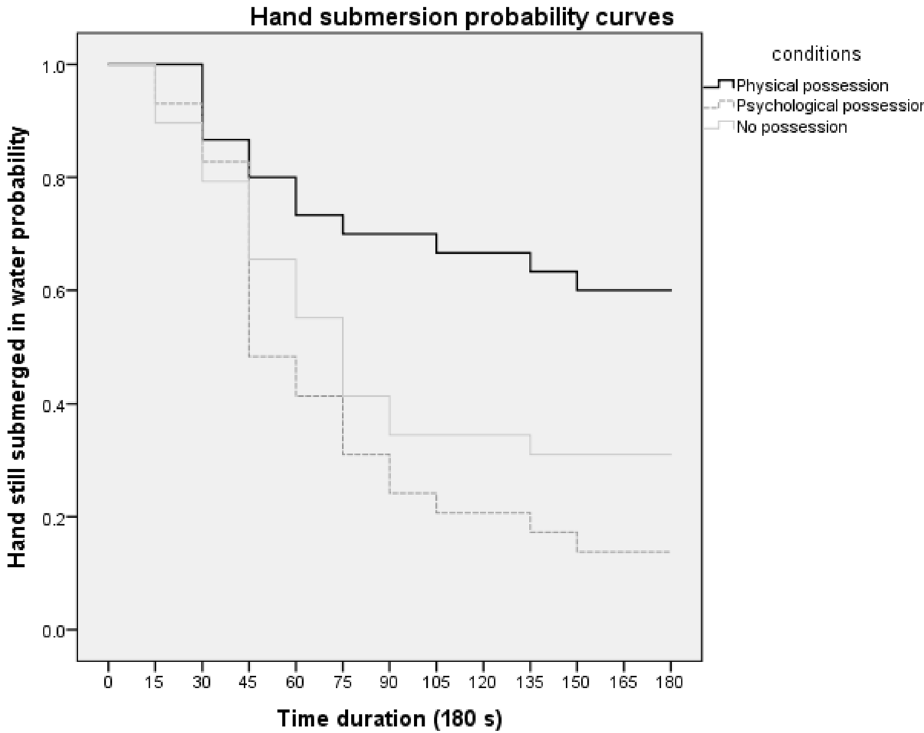
Figure 4. The hand submersion probability curves as a function of time duration for the three possession conditions. Participants physically possessing a placebo analgesic showed a higher probability of keeping their hand submerged in cold water than participants psychologically possessing the placebo analgesic and participants without possessing any placebo